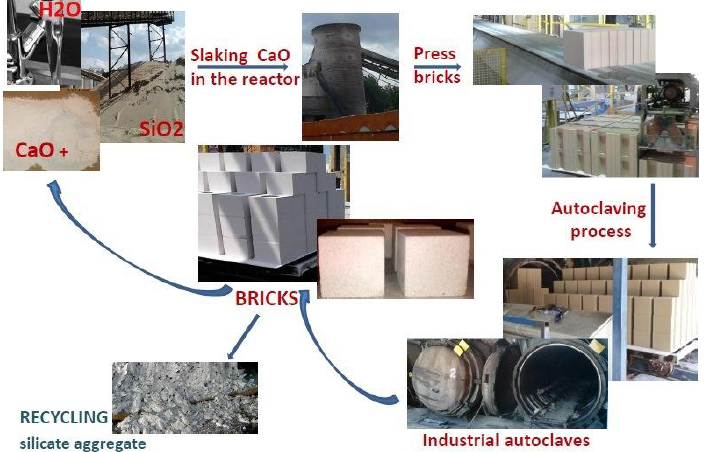
Figure 1. Production flow of traditional sand-lime bricks.